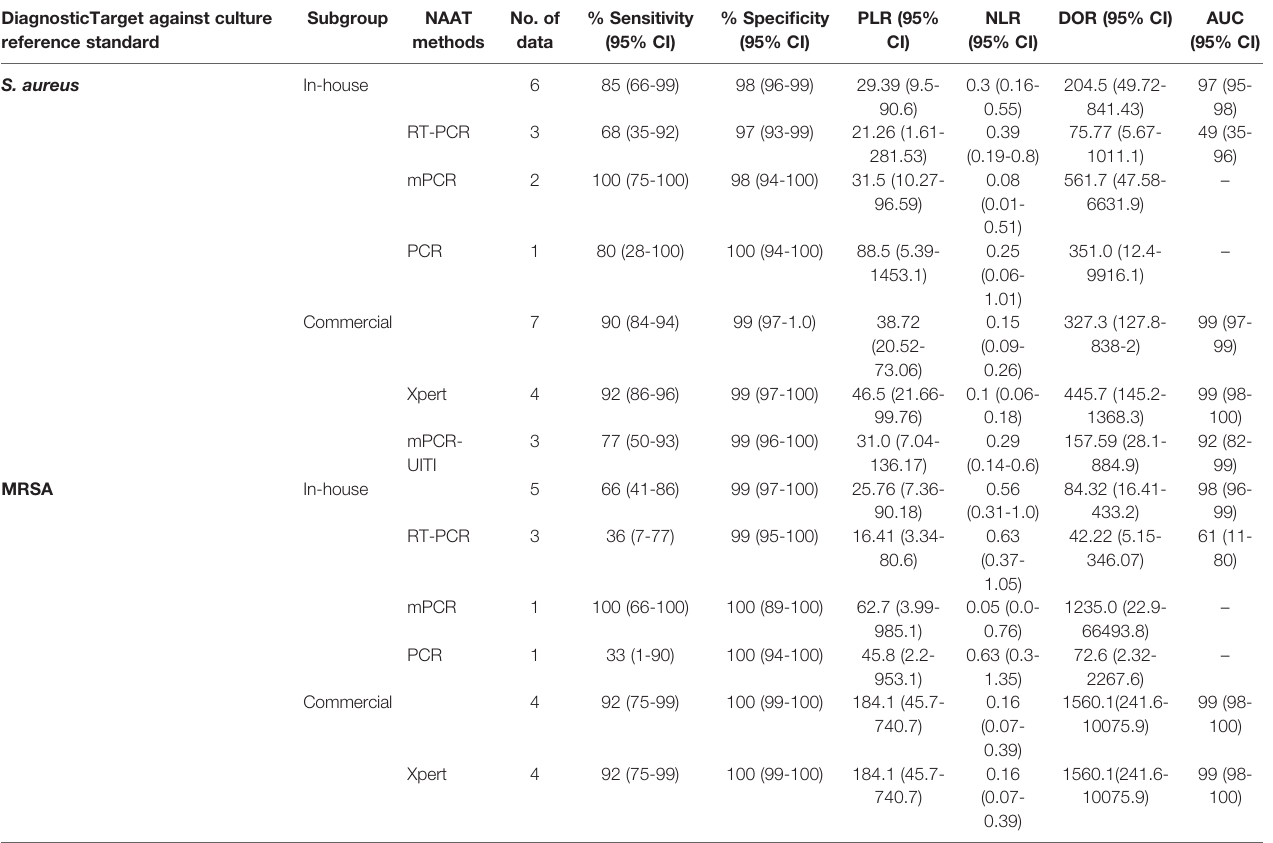
TABLE 2 | Subgroup analysis of studies using various NAA